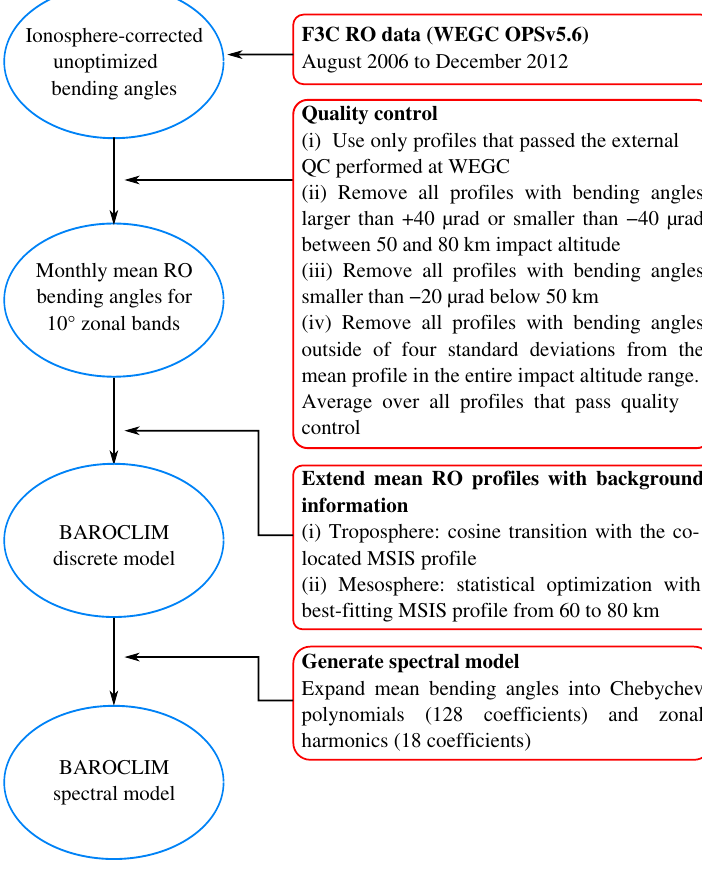
Figure 1. Flowchart of the BAROCLIM